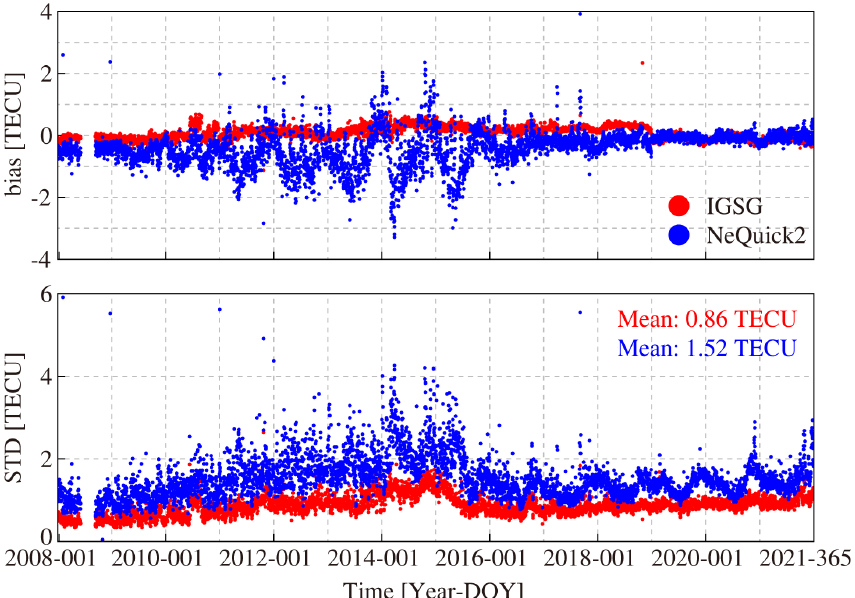
Figure 12. The time series of IGSG and NeQuick2 were assessed by the dSTEC method during the test period.